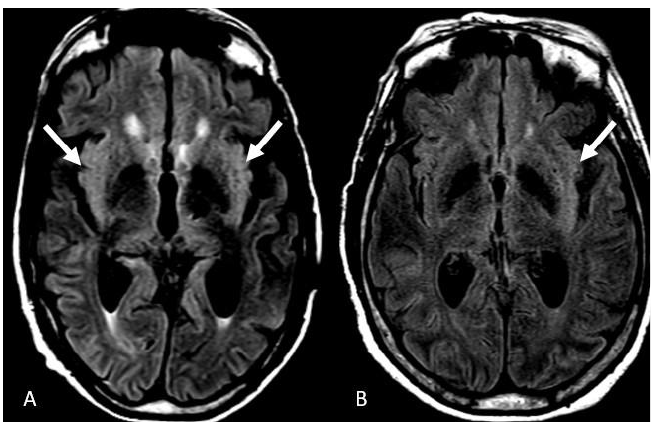
in 9 patients (23%) (Figure 3A), cerebellar micro-hemorrhages in 2 patients (5%) (Figure 3B), frontal micro-hemorrhages in 2 patients (5%) (Figure 3C), 1 each in left basal ganglia (2%) and corpus callosum splenium (2%).